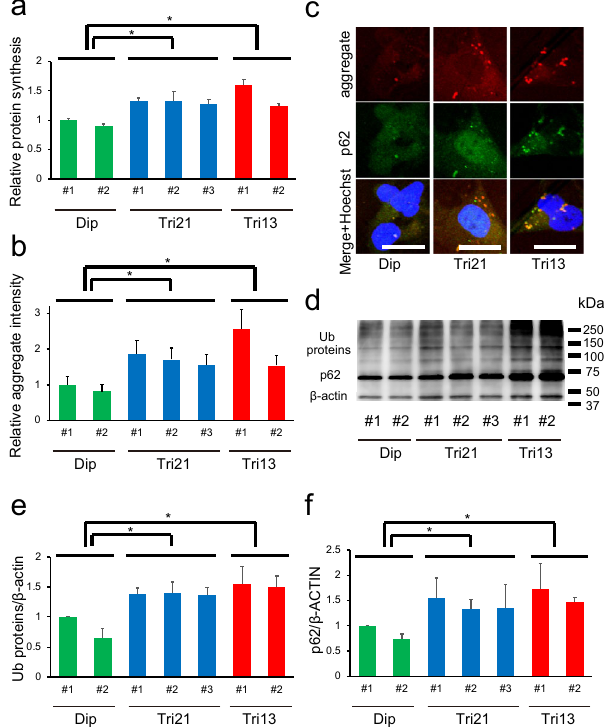
Figure 2. Perturbed protein homeostasis in human iPSC-derived NPCs in trisomy syndromes. ( a ) Relative protein synthesis per cell in NPCs. Data are presented as mean ± SEM normalized to the average of Dip #1 clone. * P < 0.05, n = 4–6 per clone. ( b ) Relative aggregate intensity per cell in NPCs. Data are presented as mean ± SEM normalized to the average of Dip #1 clone. * P < 0.05, n = 4–6 per clone. ( c ) Representative images showing immunocytochemical staining for aggregates (red); p62 (green); and merged images of aggregates, p62, and Hoechst 33342 in NPCs. Scale bar = 20 μm. ( d ) Western blot of ubiquitinylated (Ub) proteins and p62 in NPCs, using anti-Ub-protein and anti-p62 antibodies. Full immunoblot images of them are shown in Figure S2. ( e , f ) Quantification of the western blot bands of the Ub proteins ( e ) and p62 ( f ). β-Actin, loading control. Data are presented as mean ± SEM normalized to the average of Dip #1 clone. * P < 0.05, n = 4 per